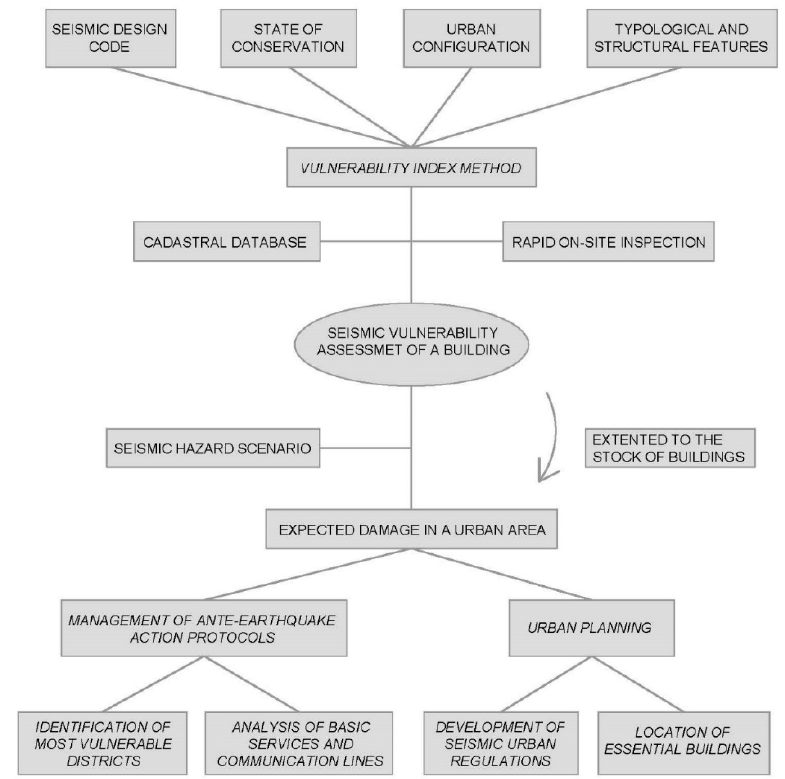
Figure 10. Diagram of the implementation of the proposed model of the LM1 method applied to the planning and management of ante-earthquake emergency scenarios. The issues developed in this contribution are italicized.